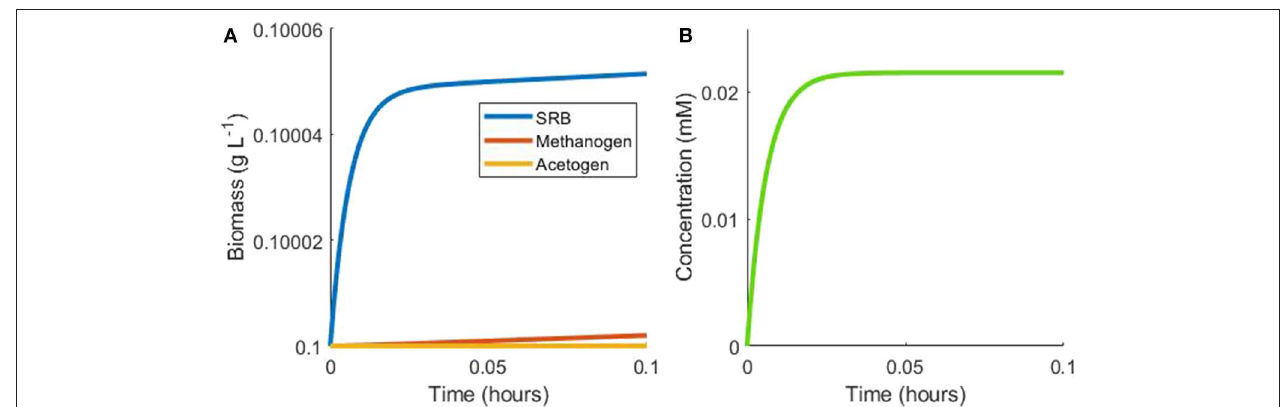
FIGURE 2 | Example simulation of early stages of batch tri-culture with lactate the sole added substrate. (A) Shows the change in microbial biomass over time and (B) shows the change in hydrogen concentration over time. The SRB rapidly oxidizes lactate to acetate and hydrogen, resulting in SRB growth and hydrogen accumulation. Once hydrogen accumulates to a level approaching the inhibitory concentration for SRB growth, its concentration remains in a pseudo-steady state with a balance between hydrogen production by the SRB and consumption by the methanogen.